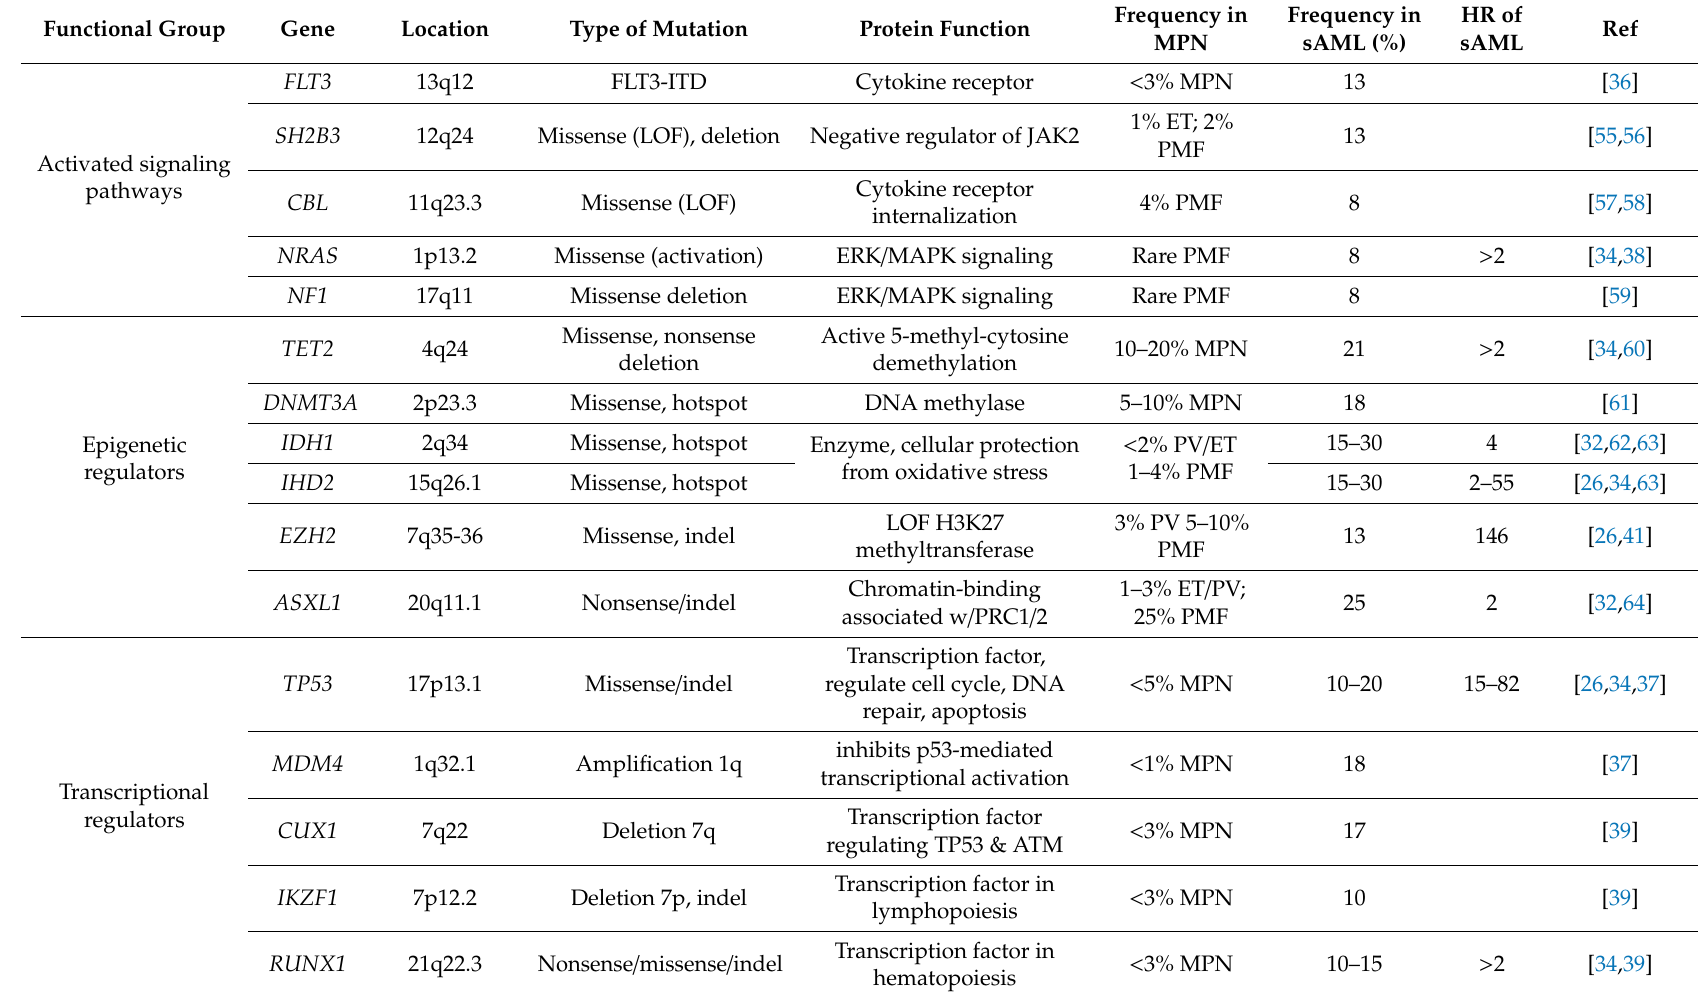
Table 4. Mutations implicated in progression from MPN-BP